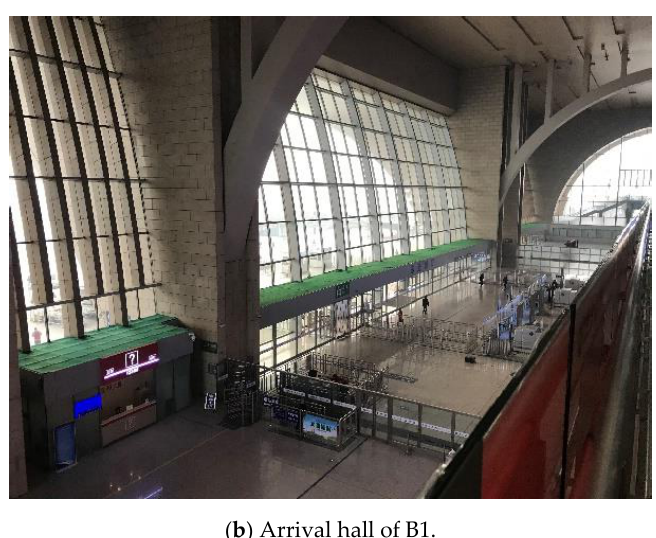
Figure 9. Glass curtain wall of high-speed railway station.